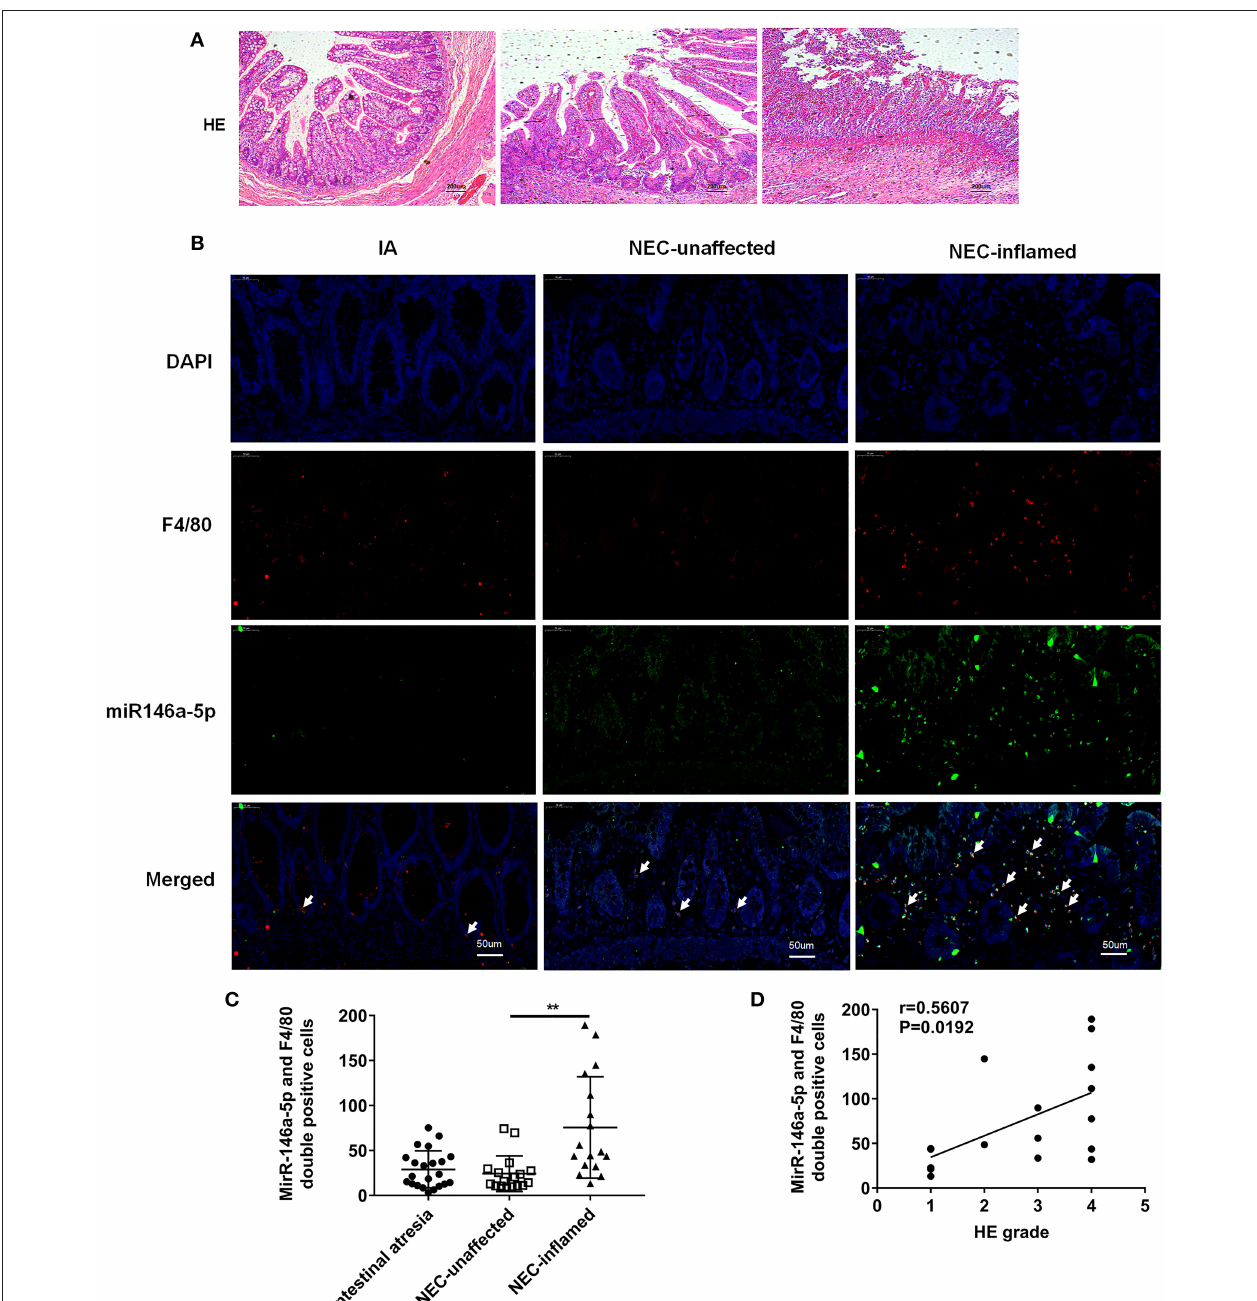
FIGURE 2 | MiR-146a-5p and F4/80 double-positive cells in the intestines of children with intestinal atresia and NEC. (A) HE representative pictures of intestinal tissue from children with intestinal atresia and NEC. (B) FISH and immunofluorescence merged representative pictures of miR-146a-5p and F4/80 double-positive cells in intestinal tissues of children with intestinal atresia and NEC. (C) The comparison of miR-146a-5p and F4/80 double-positive cell numbers in intestinal tissue between children with intestinal atresia ( n = 22) and NEC ( n = 17). (D) The correlation of miR-146a-5p and F4/80 double-positive cell number with HE grade in intestinal samples of children with NEC ( n = 17). IA, intestinal atresia; NEC-unaffected, NEC patients’ unaffected intestinal samples; NEC-inflamed, NEC patients’ inflamed intestinal samples. ** P < 0.01.